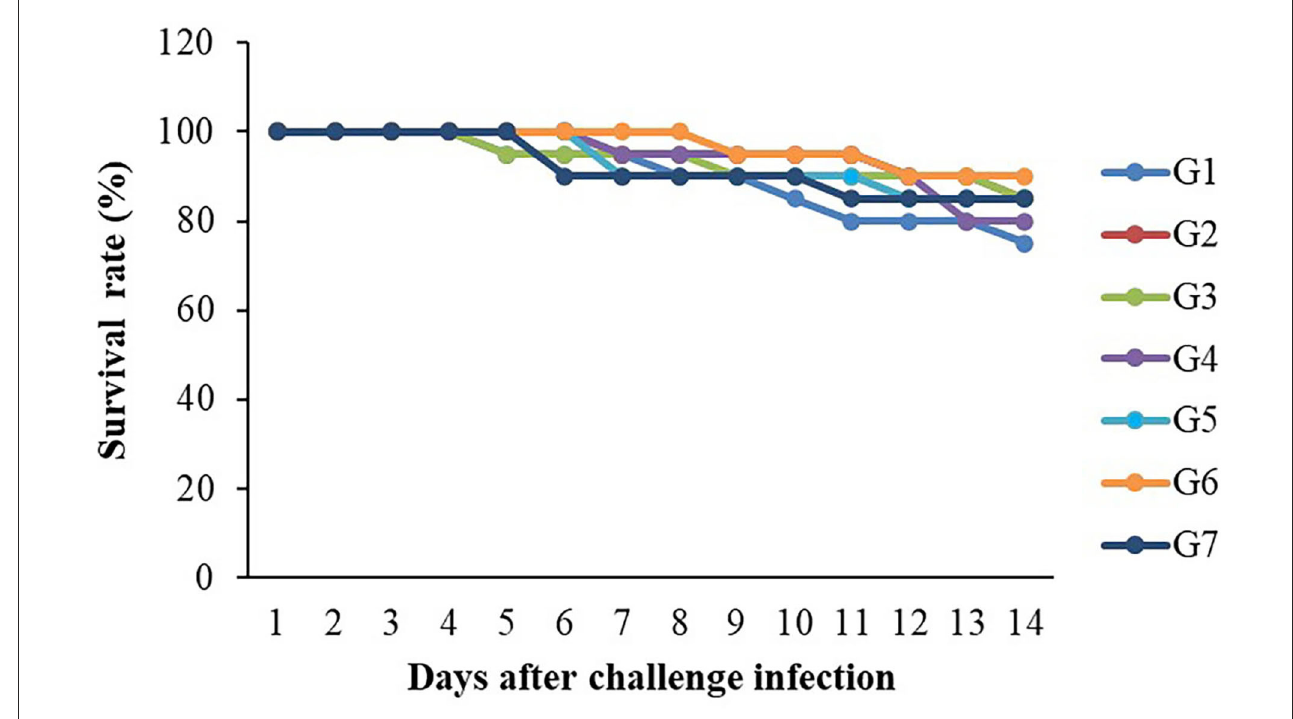
FIGURE6 Survival rates (%) of Nile tilapia fed with FOS and B. subtilis after challenge with S. agalactiae 1 × 10 8 CFU/ml ( n = 20) for 14 days.